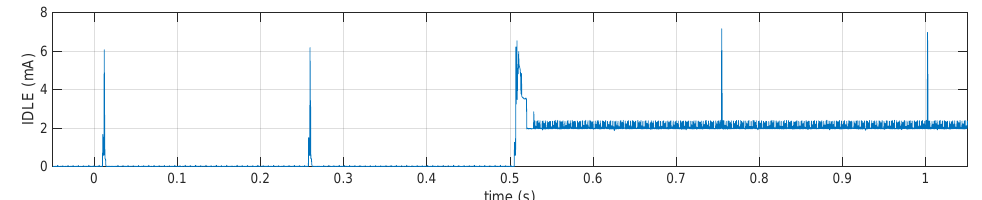
Figure 9. Current consumption of the EMG sensor node in “idle” conditions: for first half second the system was connected over BLE but otherwise idle, the spikes corresponding to radio activity every 247.5ms. On the third connection event the sensor received the command to turn on the ADC subsystem, the subsequent lower-amplitude spikes are the CPU activity resulting from the ADC interrupts at